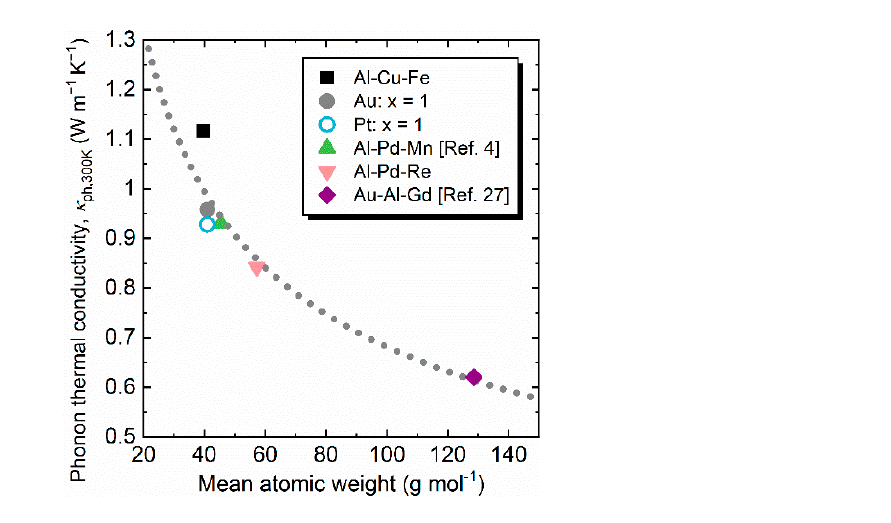
Figure 6. Phonon thermal conductivity at 300 K κ ph,300K versus mean atomic weight for various undoped icosahedral quasicrystals (QCs) and related approximant crystals (ACs): Al-Cu-Fe QC, Al-Cu-(Au,Pt)-Fe QCs, Al-Pd-Mn QC [4], Al-Pd-Re QC, and cubic-Au-Al-Gd AC [27]. The Au/Pt substitution reduced κ ph,300K down to that of Al − Pd − Mn QC [4]. The dashed curve is drawn to guide the eye.